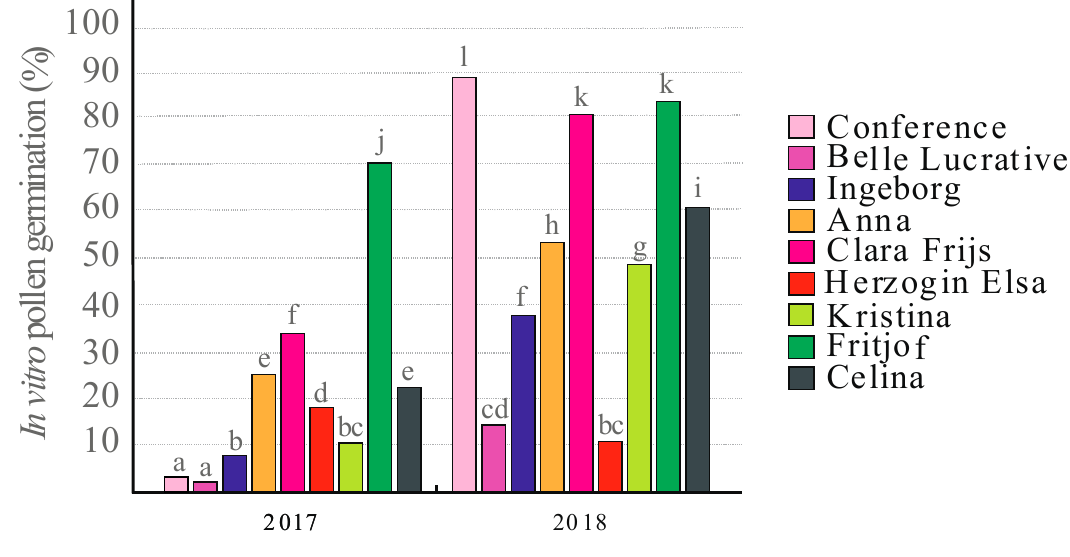
Figure 3. In vitro pollen germination (%) of nine pear cultivars in 2017 and 2018. (Different letters above the bars denote a significant difference between clones according to the LSD test, p < 0.05).